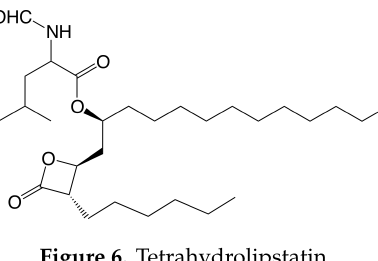
Figure 5. Tetrahydrolipstatin. Figure 6.